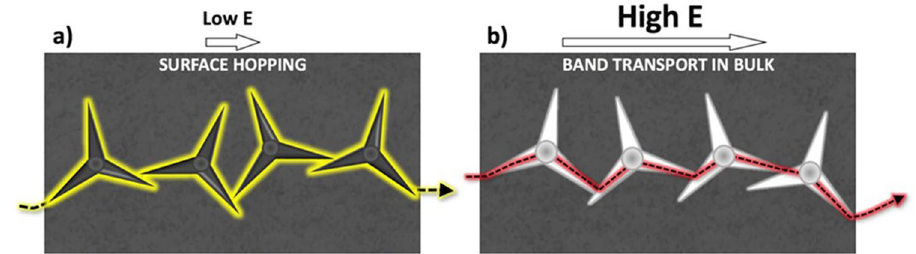
Figure 6. Schematic representation of ( a ) charge transport mechanism at low electric fields, due to thermally activated hopping, and ( b ) charge transport mechanism at high electric fields, due to band transport in